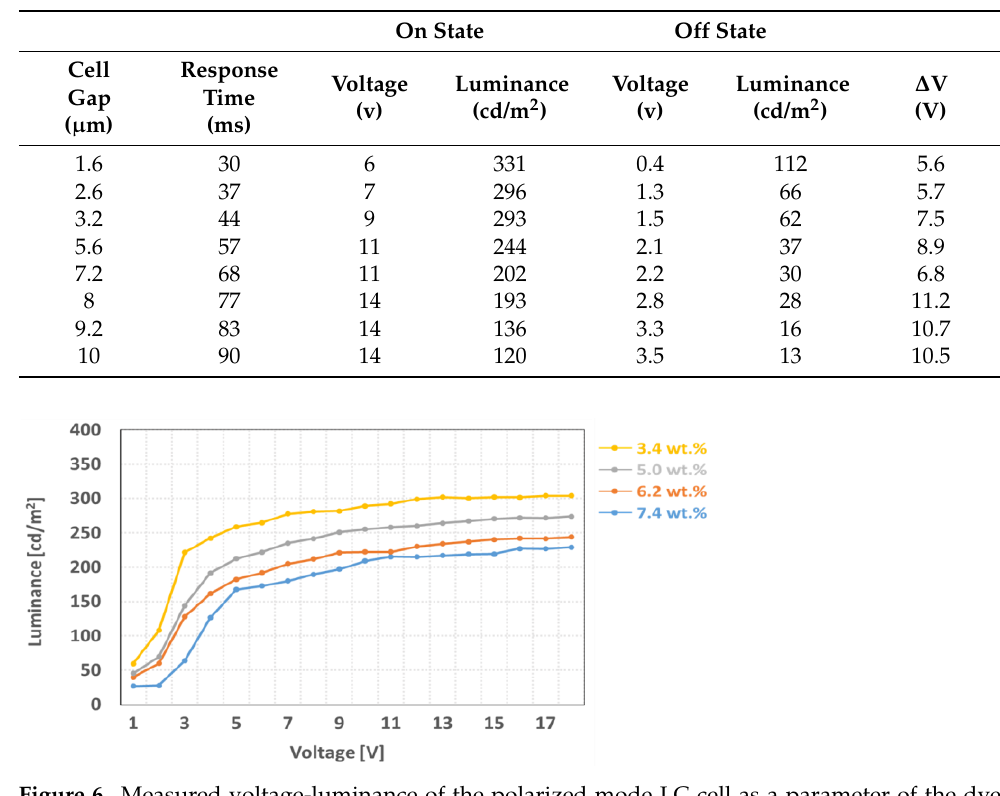
Table 1. Measured electro-optical characteristics of the polarized mode LC cell as a parameter of cell gap at 6.2 wt % of the dichroic dye concentration.